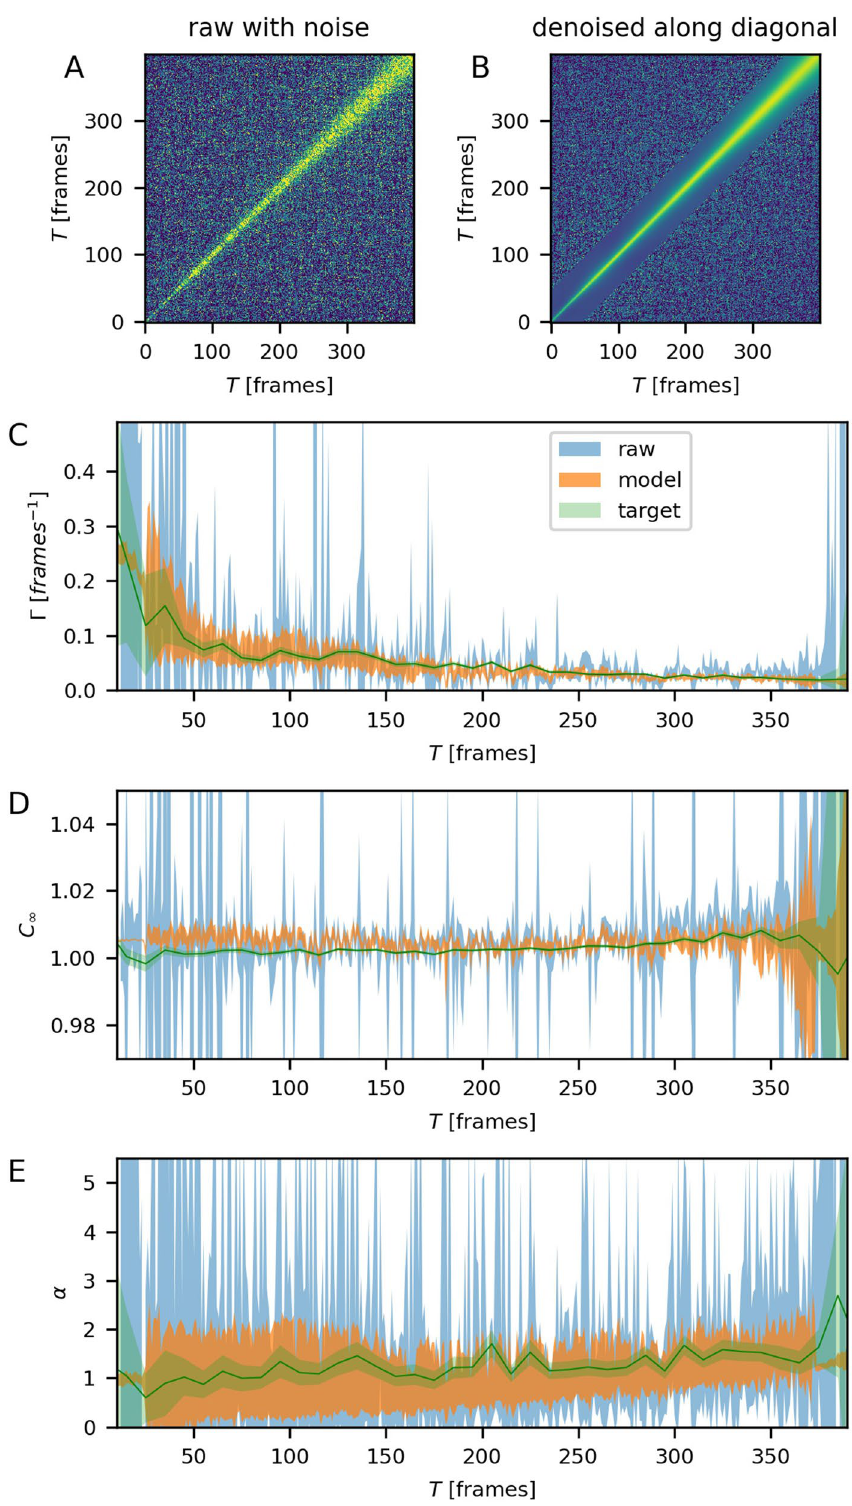
Figure 6. Model application for the case of non-equilibrium dynamics. ( A ) 2TCF calculated from reduced ROI. ( B ) The same 2TCF after the model is applied along its diagonal. Temporal evolution of Ŵ ( C ), C ∞ ( D ) and α ( E ) parameters extracted from the noisy raw data, denoised data and the target